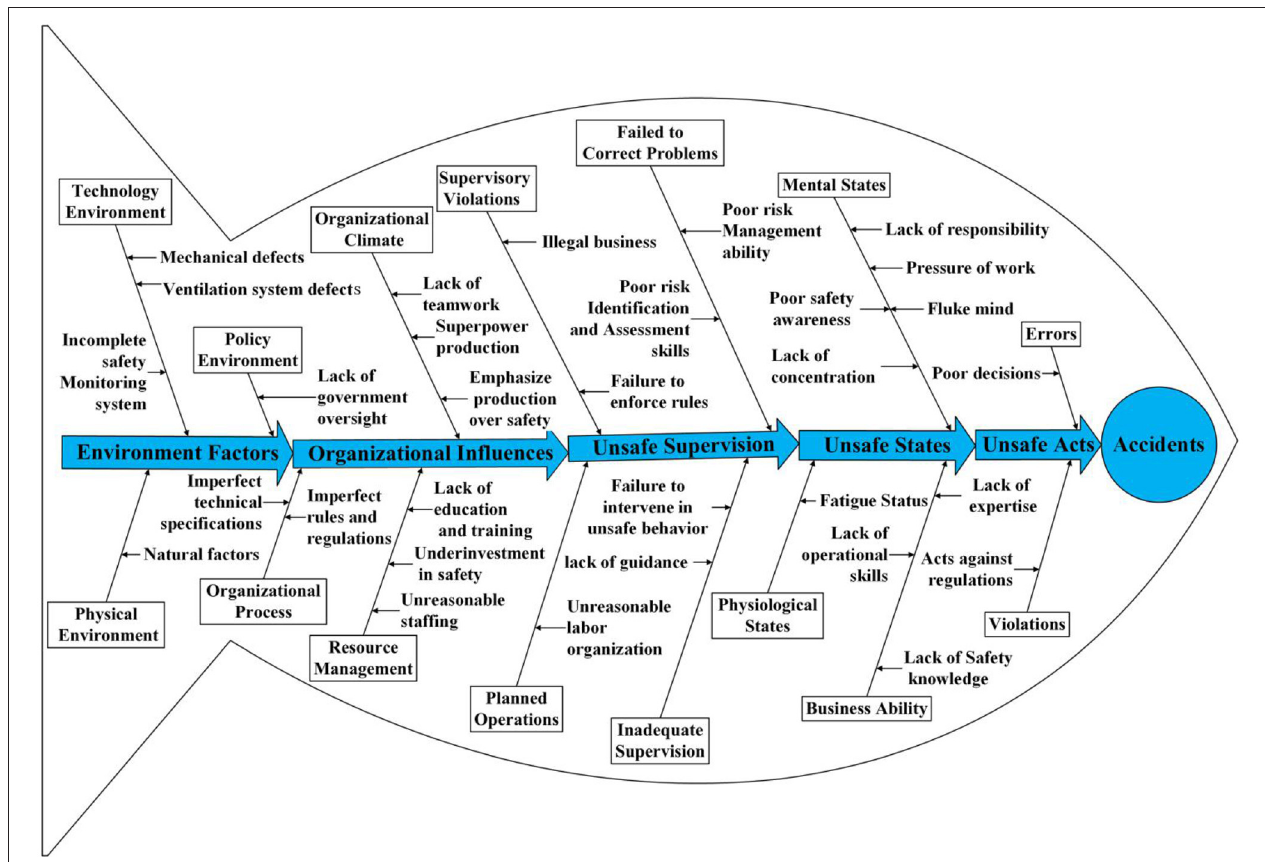
FIGURE 5 | The conceptual model of risk factors of the miners’ unsafe